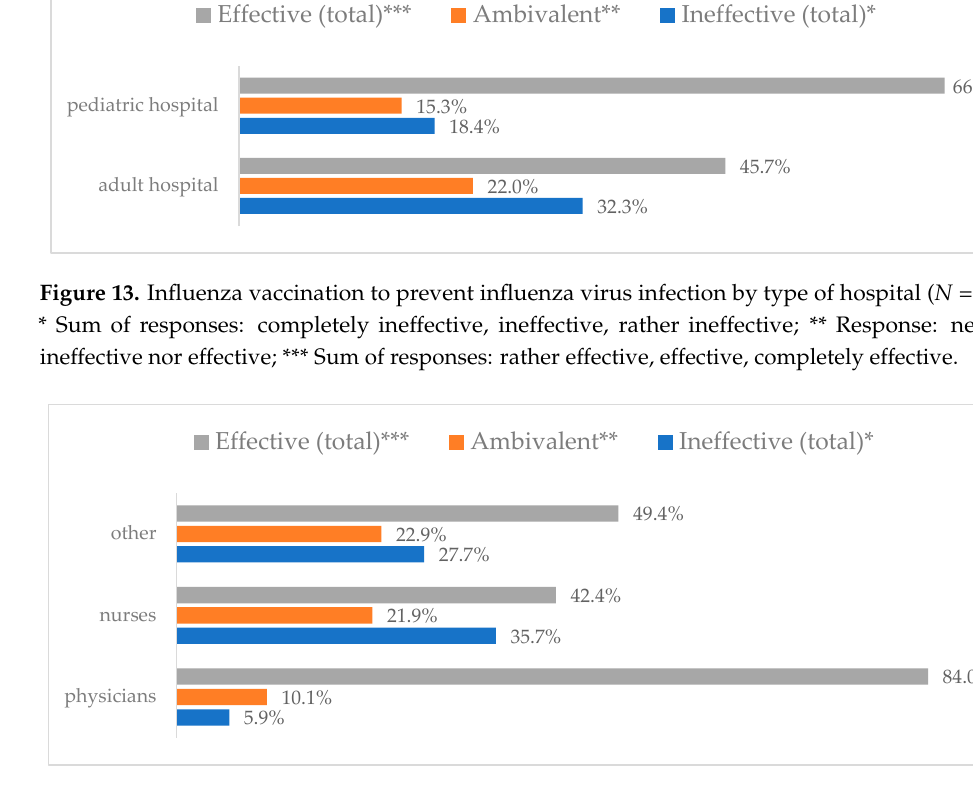
Figure 15. Influenza vaccination to prevent influenza virus infection by seniority ( N = 905). *Sum of responses: completely ineffective, ineffective, rather ineffective; **Response: neither ineffective nor effective; ***Sum of responses: rather effective, effective, completely effective. The results presented above regarding clinical approaches to preventing influenza virus infection and attitudes toward the effectiveness of influenza vaccination as a form of preventing influenza virus infection positively verify hypotheses H1 and H3. H1 . Physicians show greater belief in clinical methods (hand washing, wearing a mask covering the mouth and nose, vaccination) of preventing influenza virus infection than nurses. H3 . Influenza vaccination is perceived to prevent influenza virus infection more often among pe- diatric hospital staff than adult hospital staff and physicians than nurses.